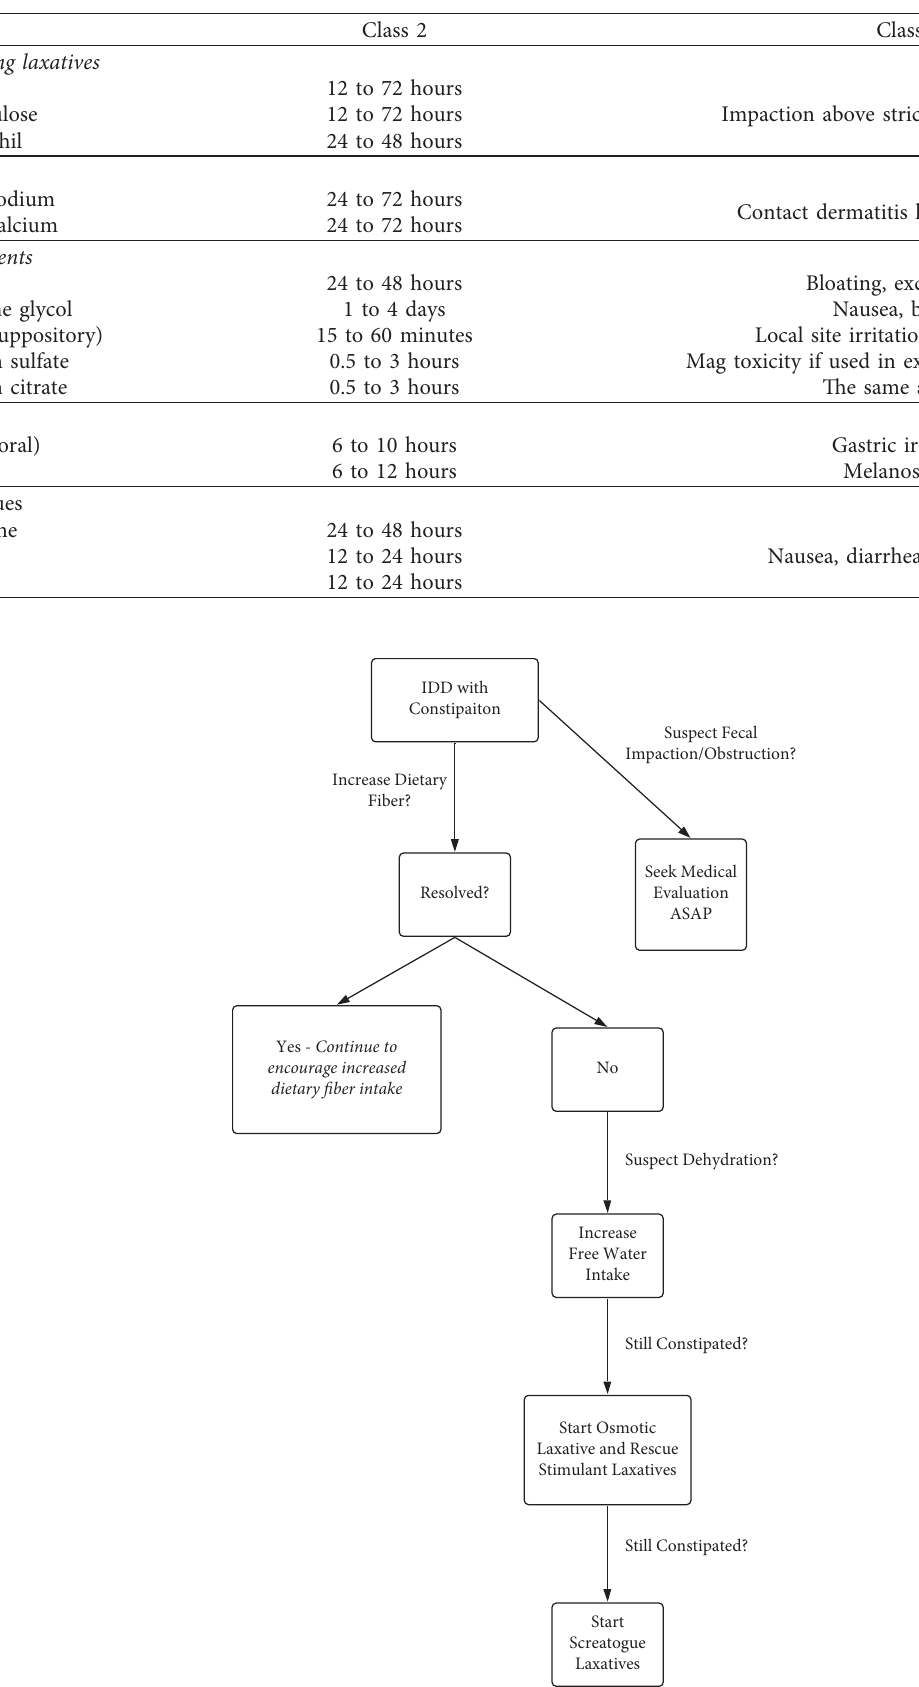
Figure 2: Treatment algorithm: a flow chart that helps PCPs in the step-by-step management of constipation in adults with